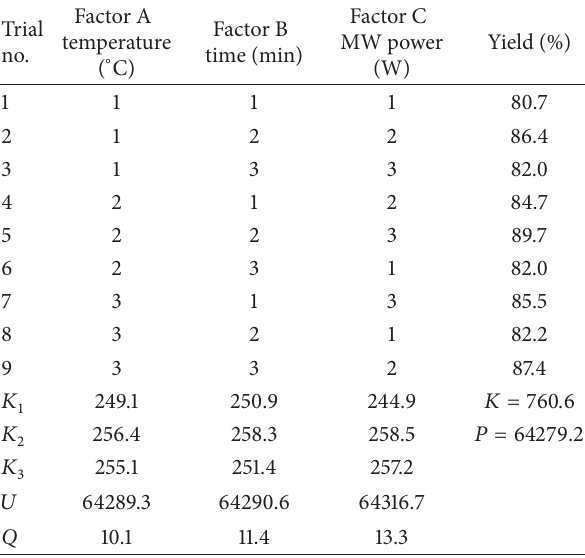
Table 4: Orthogonal experiment on synthesis of 𝛼 -acetylamino- 𝛽 - (3,4-diacetoxyphenyl)acrylic acid.